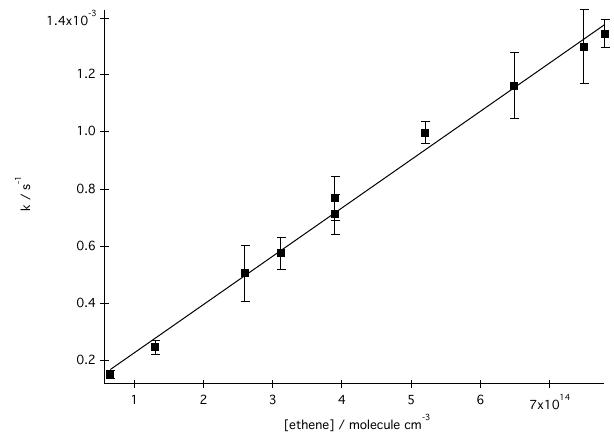
Fig. 3. Temporal plot of ozone decay to yield k 0 , with an initial [ethene] of 10.5ppm. Figure 4 : Second-order plot of k ′ vs . [ethene].